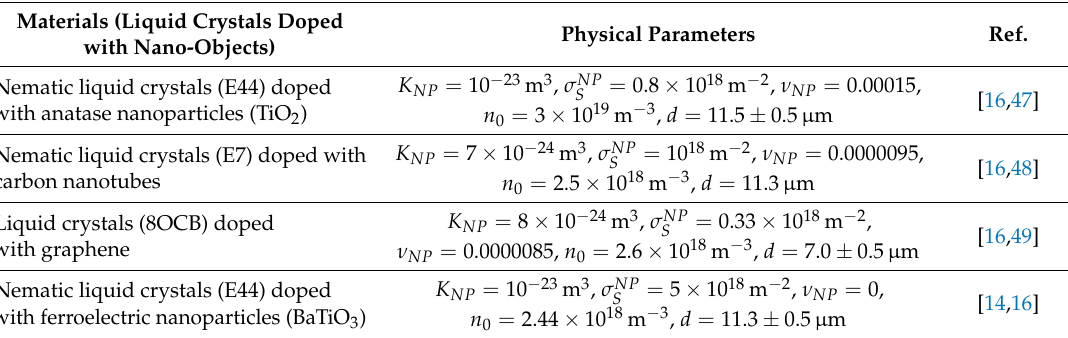
Table 1. Examples of existing experimental